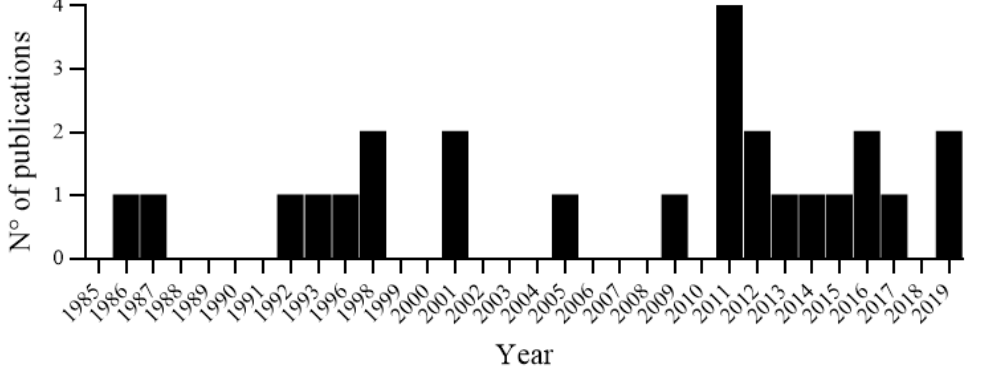
Figure 3. Histogram of publications per year for Erythrina suberosa Roxb. from 1985 to 2019 (accessed